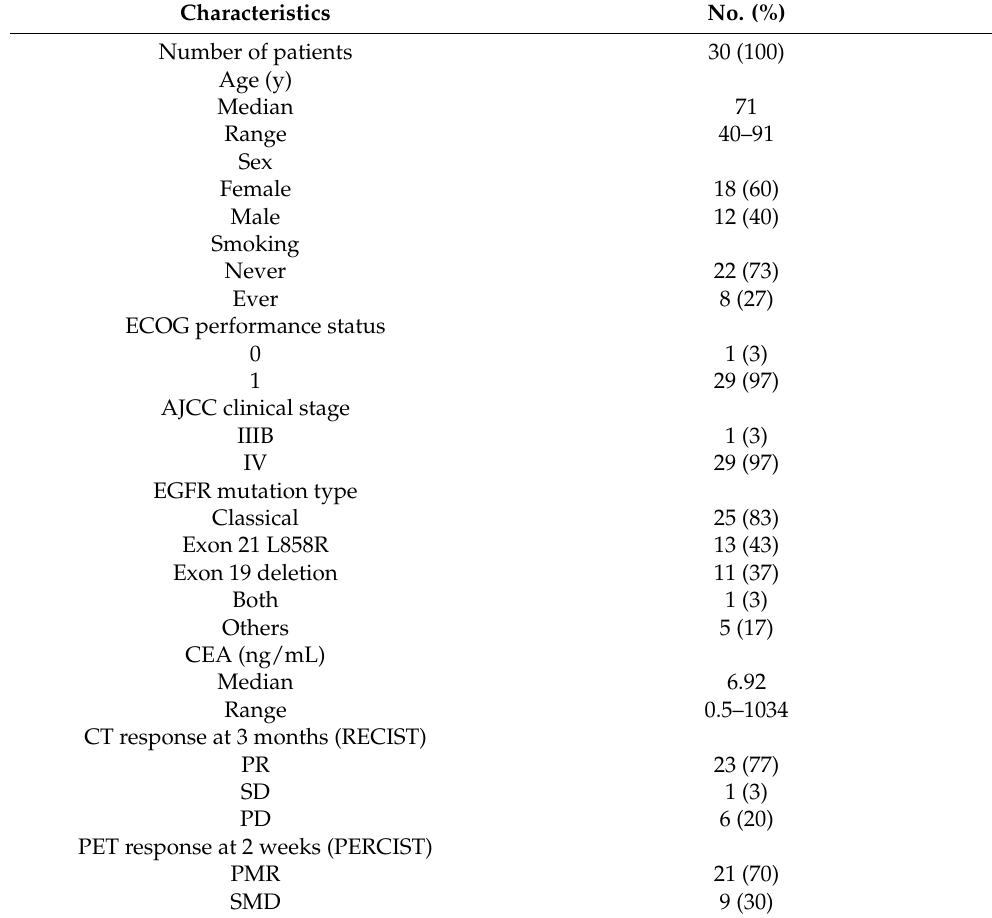
Table 1. Patient